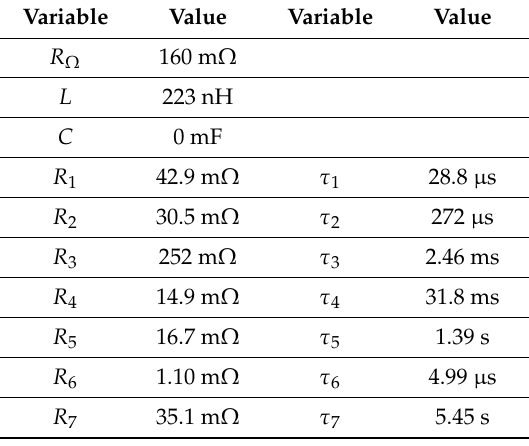
Table 5. Identified polarization contributions of the vanadium redox-flow battery comprising ohmic resistance, inductivity, capacitance, resistive-capacitive, and resistive-inductive